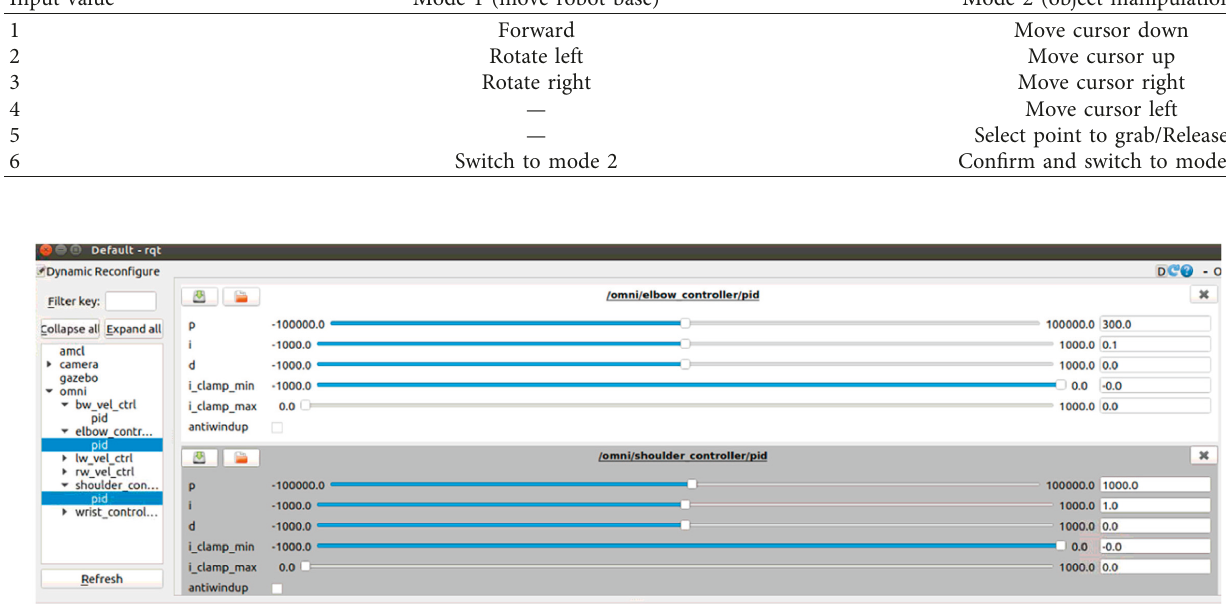
Figure 15: Initial PID values for different joints.